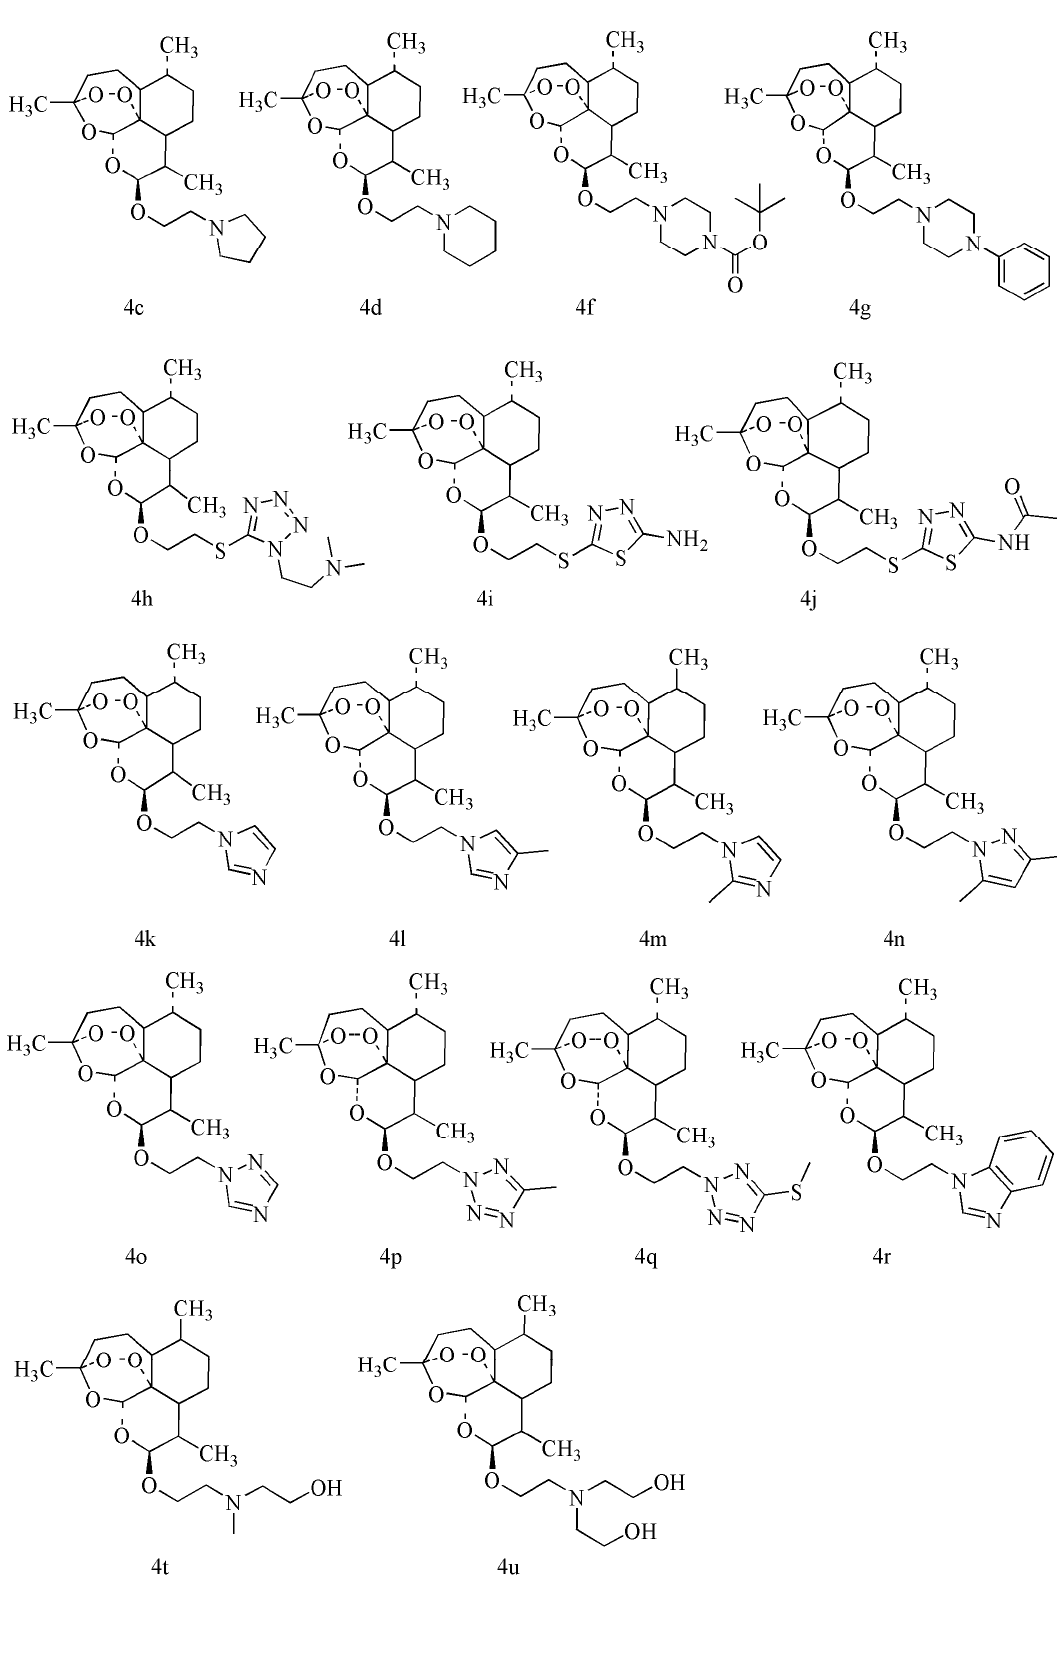
Figure 2. The structures of 17 new